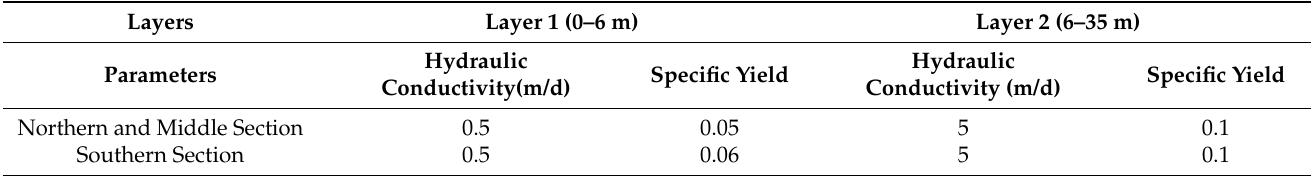
Table 4. The validation values of the hydraulic conductivity and specific yield in the model.